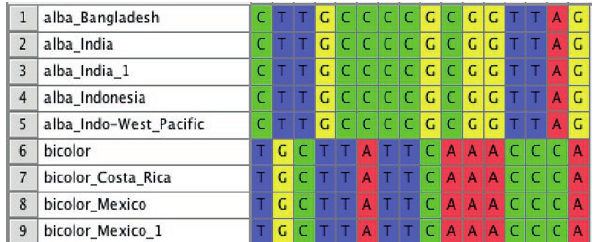
Figure 12. ITS Barcode sequences differentiating Avicennia